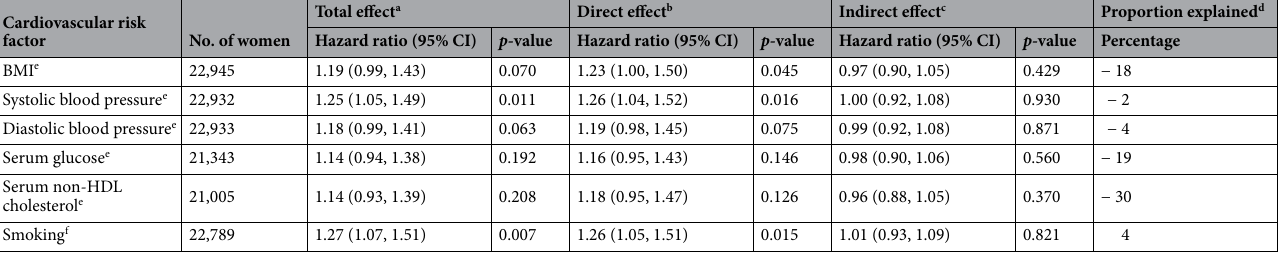
Table 5. Decomposition of the association between history of preterm birth and cardiovascular disease into direct and indirect effects. a Association between history of preterm birth and CVD compared to women with history of term birth. Hazard ratio differs from that in Table 2 due to additional adjustment for age of mediator ascertainment. b Part of the association between history of preterm birth and CVD that is not explained by the cardiovascular risk factor. c Part of the association between history of preterm birth and CVD that is explained by the cardiovascular risk factor. d Proportion excess cardiovascular risk in women with history of preterm birth that is explained by cardiovascular risk factor. e Estimates are adjusted for age (used as time scale in the Cox proportional hazards model), age at measurement of the cardiovascular risk factor, highest obtained educational level, age at first birth, parity, first birth in the Medical Birth Registry of Norway, maternal height and birth year. f Estimates are adjusted for age (used as time scale in the Cox proportional hazards model), highest obtained educational level, age at first birth, parity, first birth in the Medical Birth Registry of Norway, maternal height and birth year. CVD cardiovascular disease, CI confidence interval, BMI body mass index, HDL high-density